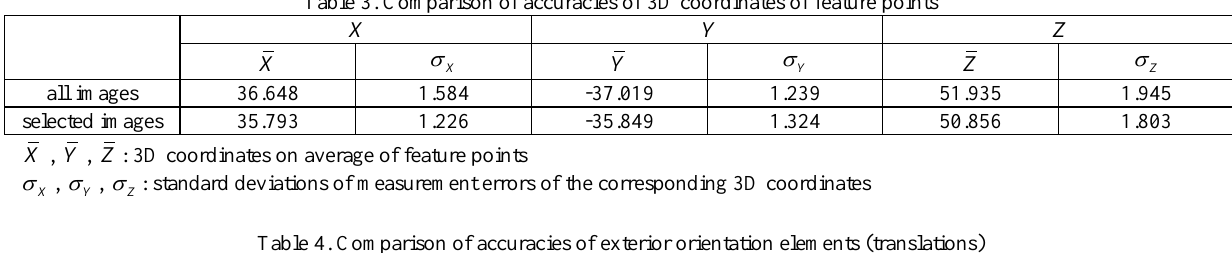
Table 4. Comparison of accuracies of exterior orientation elements (translations) X Y